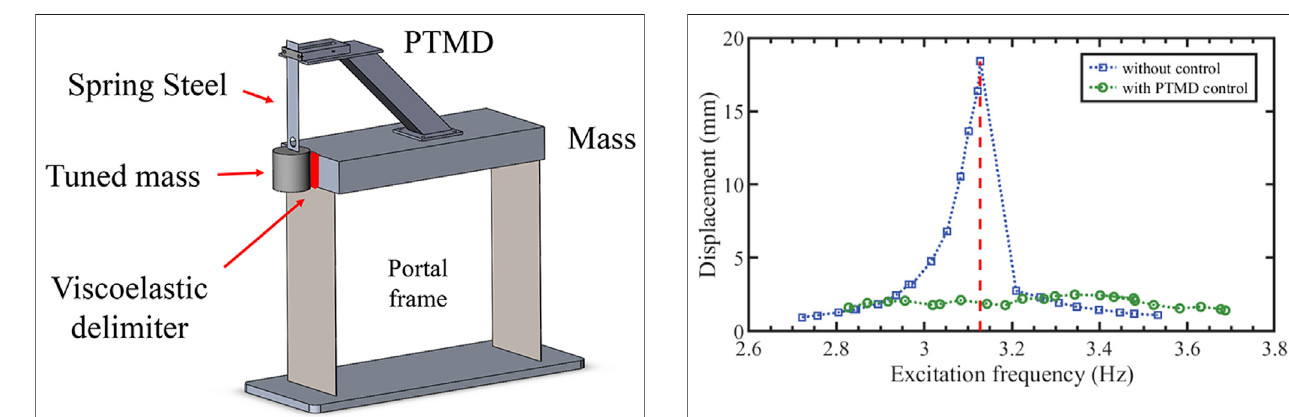
FIGURE7| Displacementresponseofportalframeinfrequencydomain.